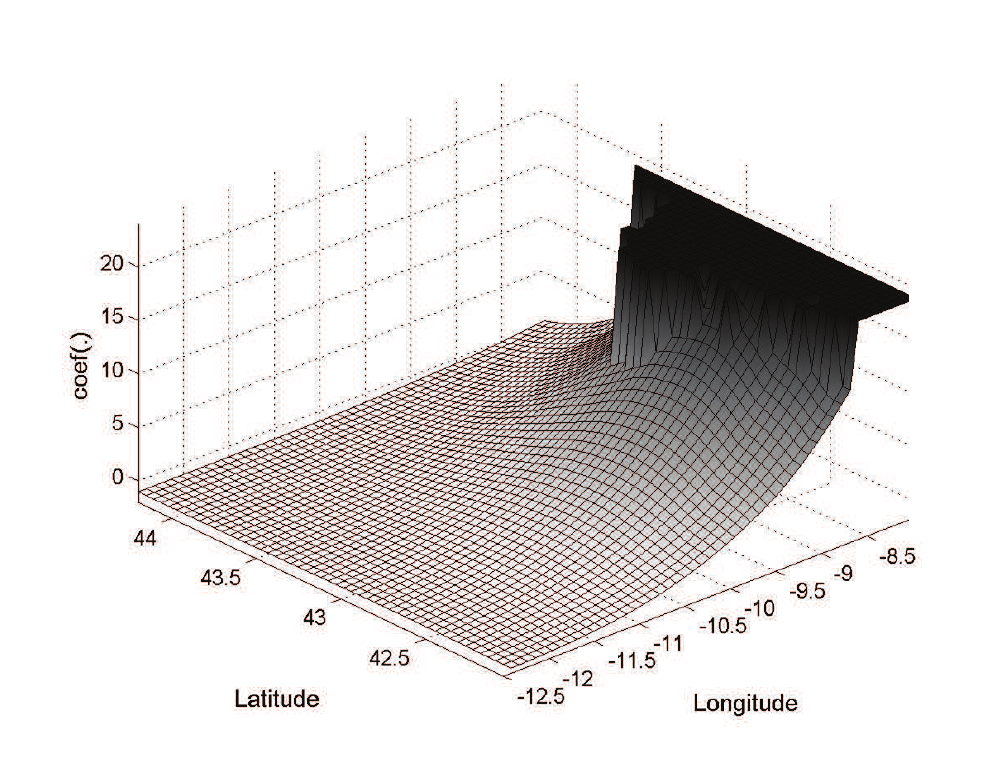
Fig. 1 Graphical representation of the function coef(.) with λ 1 = 20, λ 2 = 4 and λ 3 =